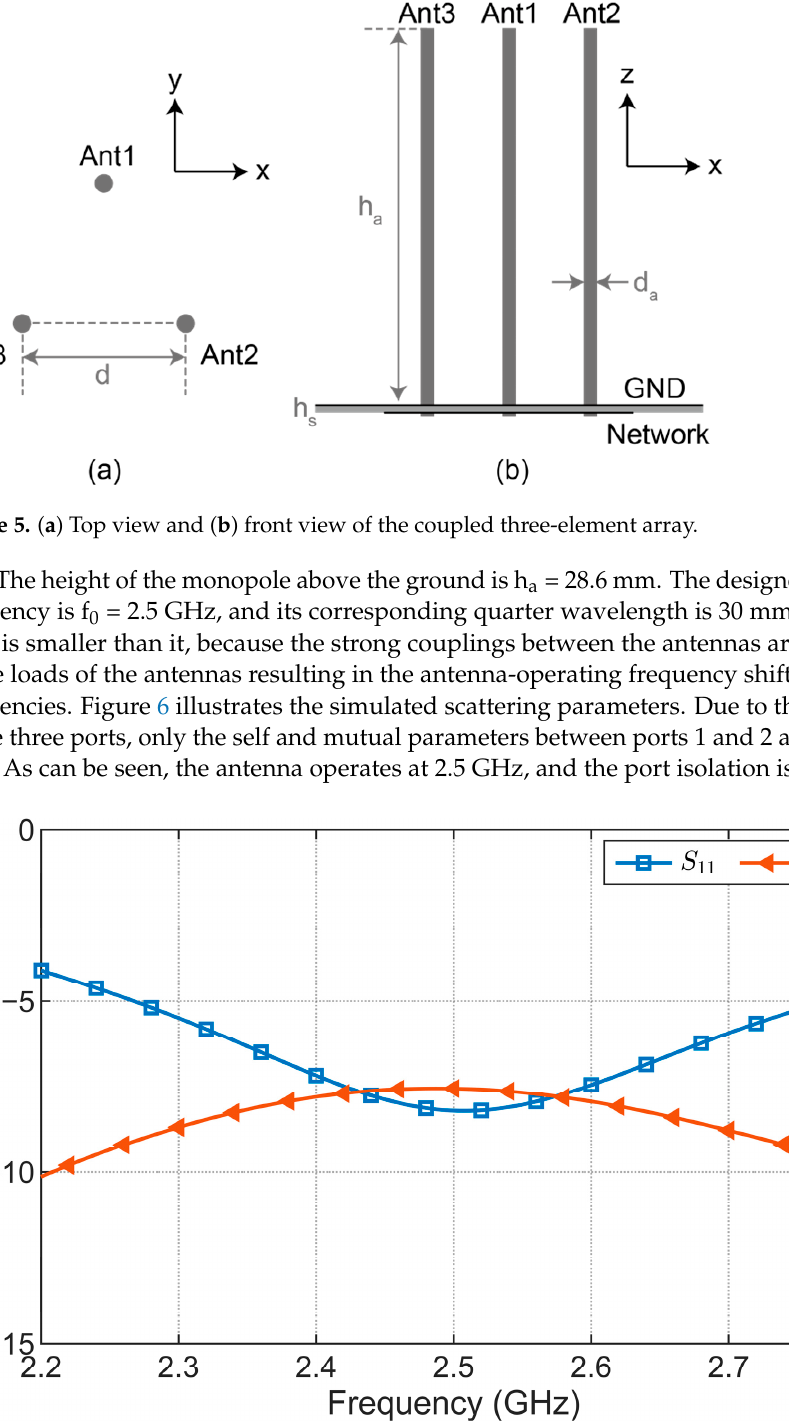
Figure 6. Simulated S parameters of the coupled array.